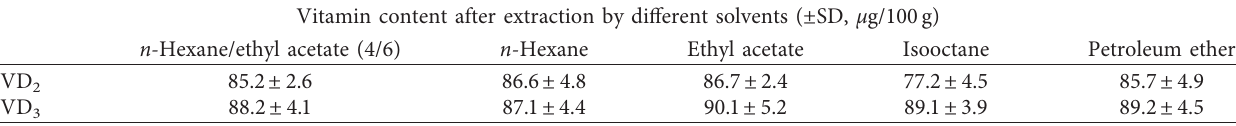
Figure 4: Levels of VD 2 with different saponification time ( μ g/100g). Table 2: Obtained results with different extraction solvents ( n � 6).